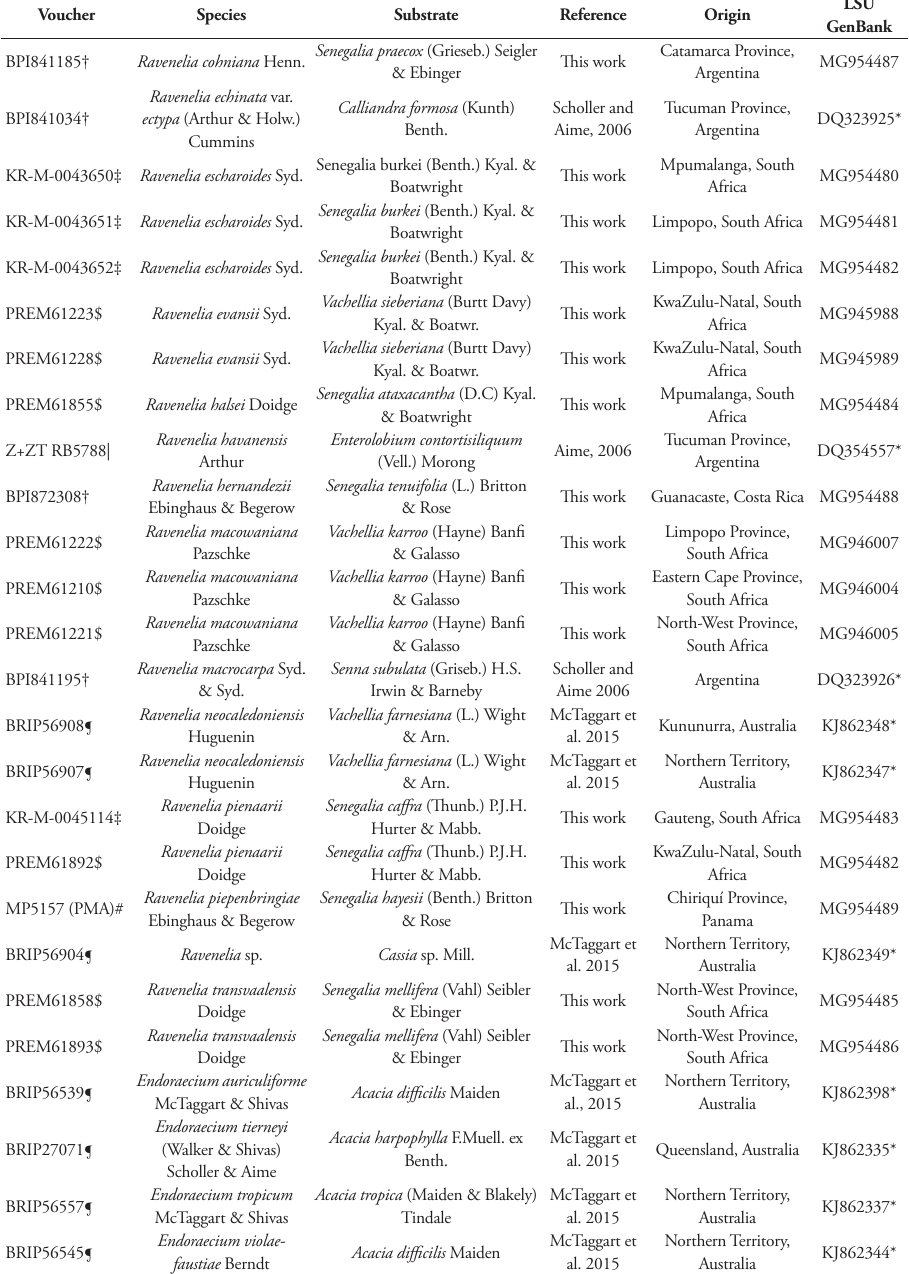
Table 1. Specimens analysed in this study, including GenBank Accession Numbers. Published references are given for sequences obtained from GenBank. †: BPI (U.S. National Fungus Collections, USA); ‡: KR (Staatli- ches Museum für Naturkunde Karlsruhe, Germany); $: PREM (Plant Protection Research Institute, South Afri- ca); |: Z+ZT (Universität Zürich, Switzerland and Eidgenössische Technische Hochschule Zürich,